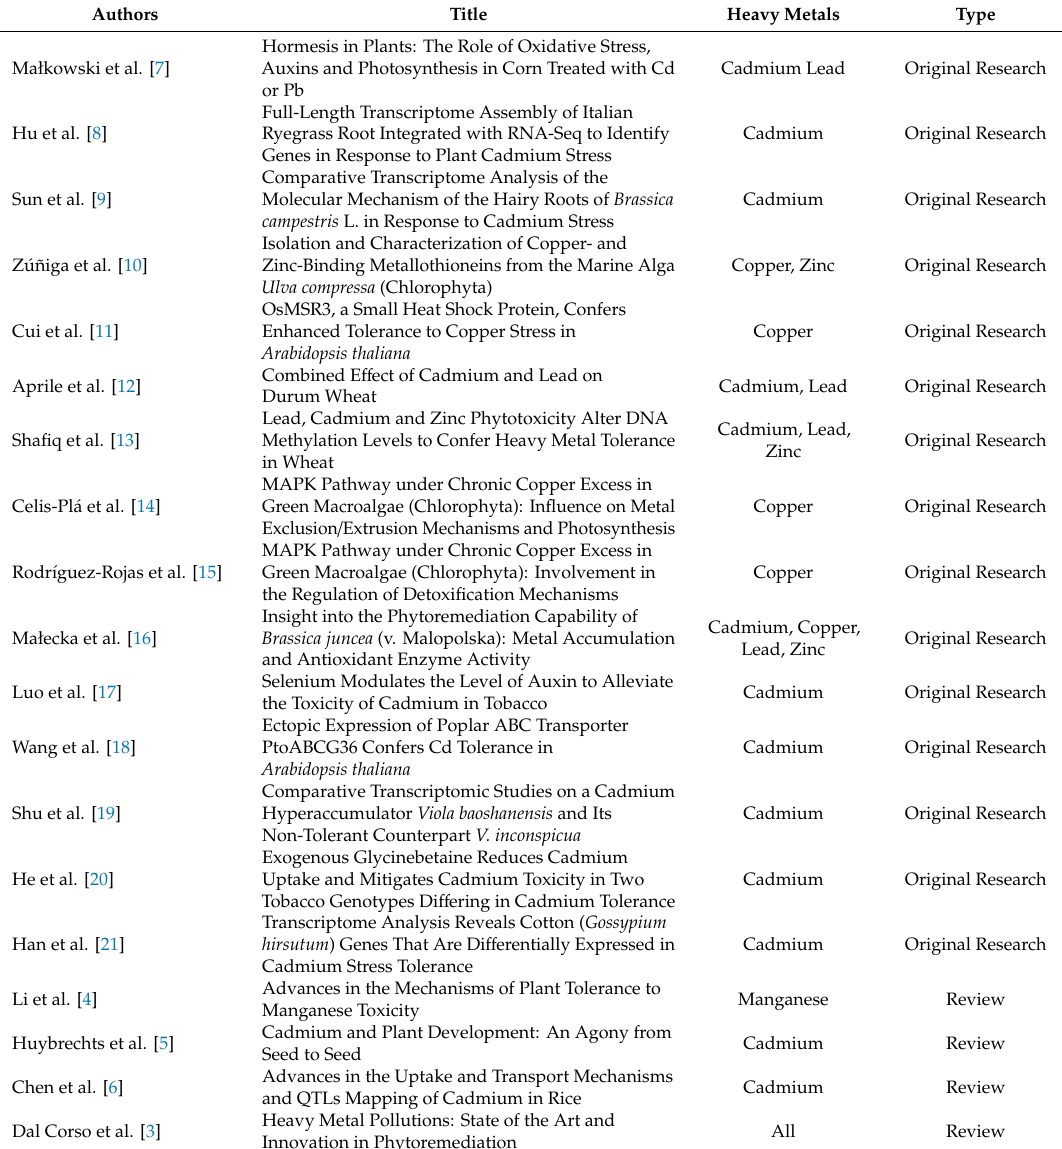
Table 1. Contributors to the special issue “Heavy Metals Accumulation, Toxicity, and Detoxification in Plants”. ABC: ATP-binding